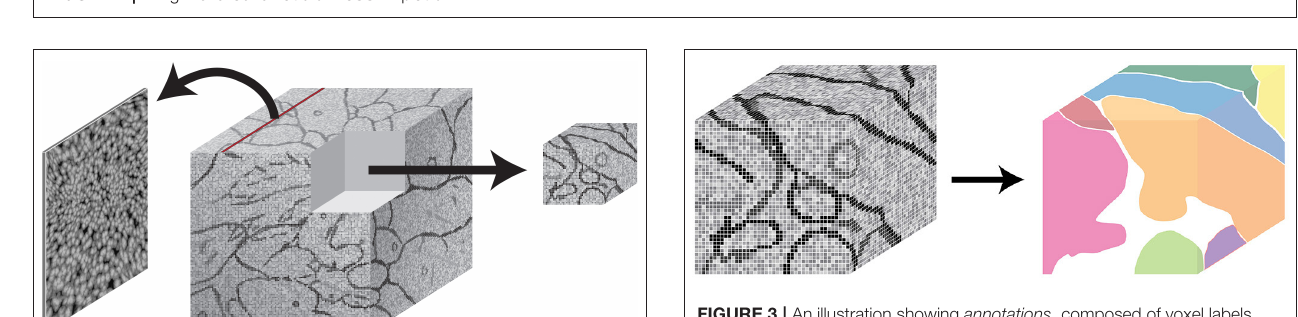
FIGURE 1 | A high-level schematic of BossDB platform.